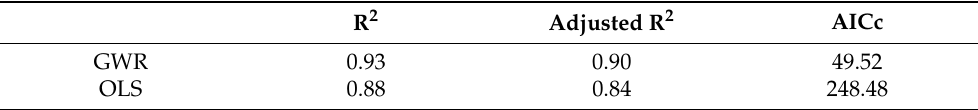
Table 7. Statistic coefficients for GWR and